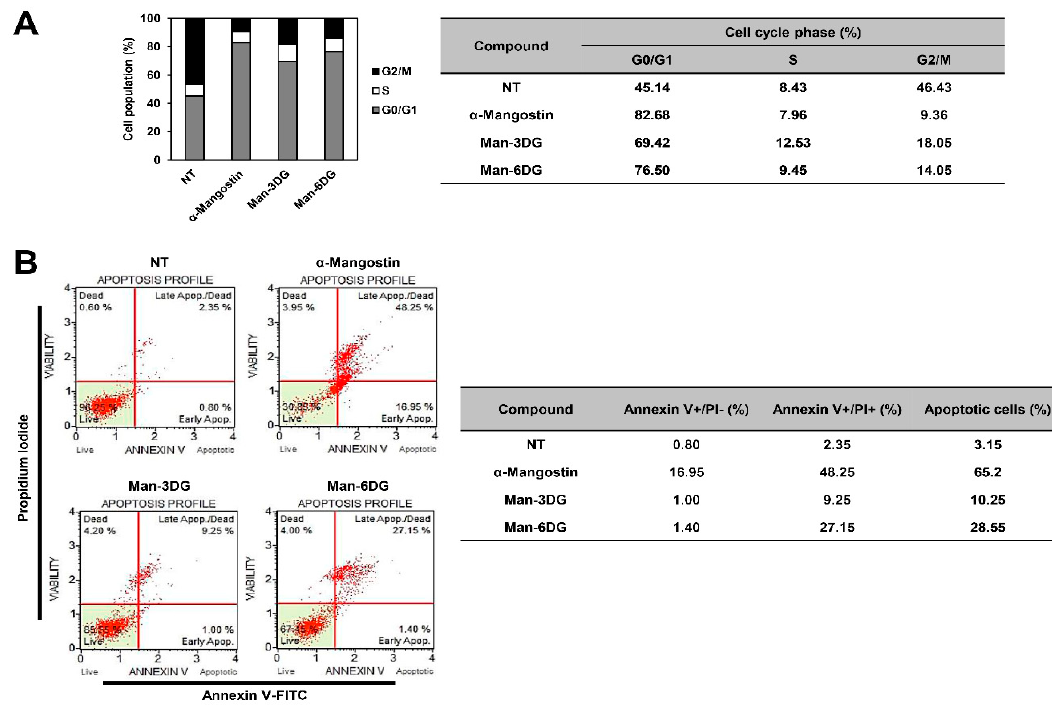
Figure 4. The effects of α -mangostin glycosides on the cell cycle and apoptotic cell death of Hep3B cells. ( A ) The cell cycle distribution of Hep3B cells was evaluated through flow cytometry after the treatment of α -mangostin, Man-3DG, and Man-6DG (10 µ M) for 24 h. ( B ) Hep3B cells were treated using three compounds (40 µ M) for 24 h. Apoptotic cells were determined through flow cytometry analysis following annexin V-FITC and propidium iodide (PI) dual labeling.